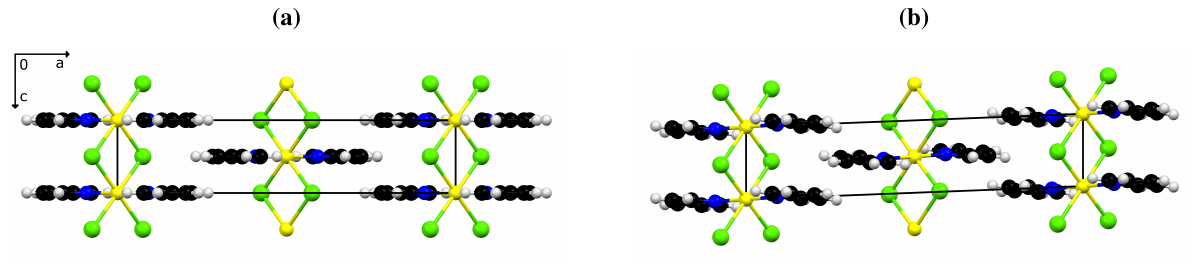
Figure 1. View on crystallographic B -face of (a) : 1 α and (b) : 1 β (color code: Cd: yellow, Br: green, N: blue, C: black, H: grey)